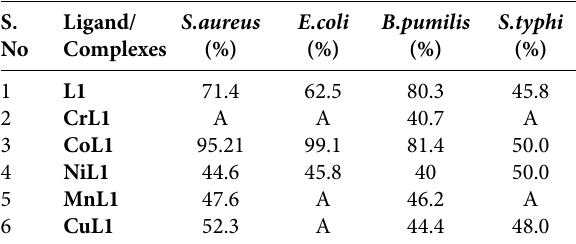
Table 5 . Antibacterial activities of the MBHA and the complexes (compound 4-8